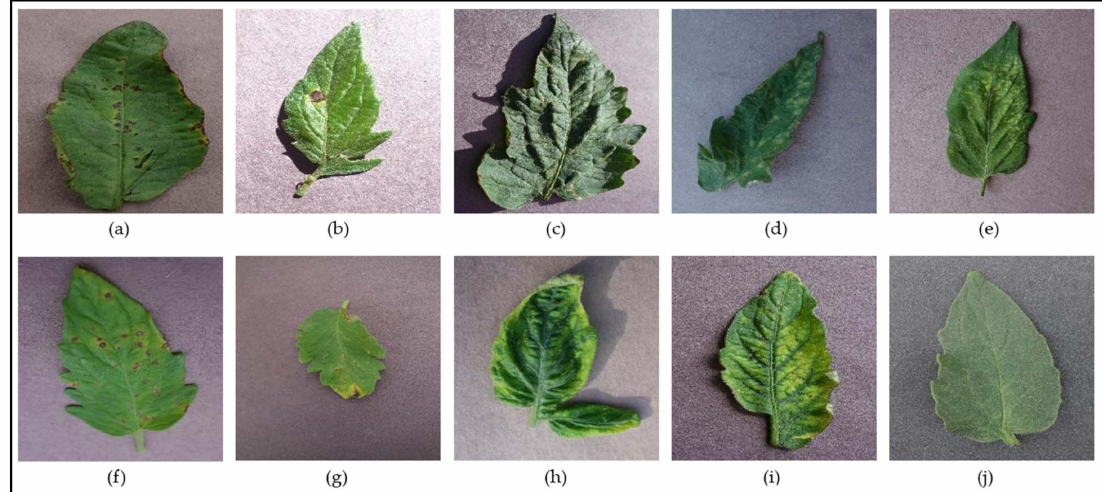
Figure 3. Examples of leaves from the different classes supported for the Tomato species in the PlantVillage dataset—( a ) Tomato Bacterial Spot ; ( b ) Tomato Early Blight ; ( c ) Tomato Target Spot ; ( d ) Tomato Leaf Mold ; ( e ) Tomato Two-Spotted Spider Mite ; ( f ) Tomato Septoria Leaf Spot ; ( g ) Tomato Late Blight ; ( h ) Tomato Yellow-Leaf Curl Virus ; ( i ) Tomato Mosaic Virus ; ( j ) Tomato Healthy .